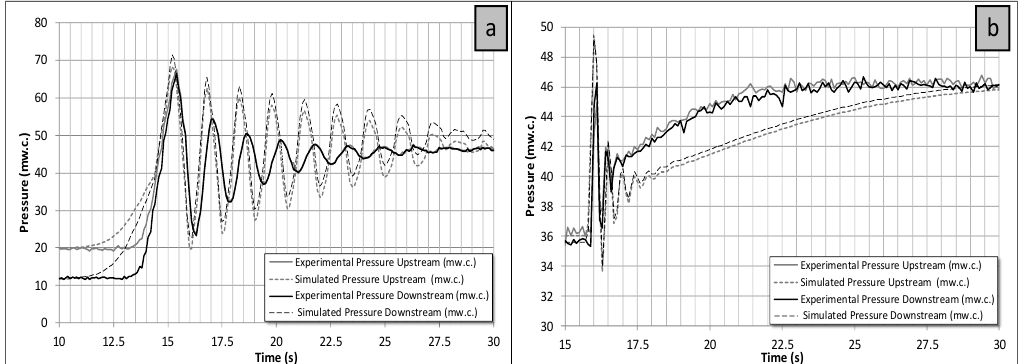
Figure 10. Experimental and simulated pressure values along time in a fast closure manoeuvre ( t = 2 s): ( a ) radial and ( b ) axial machine.